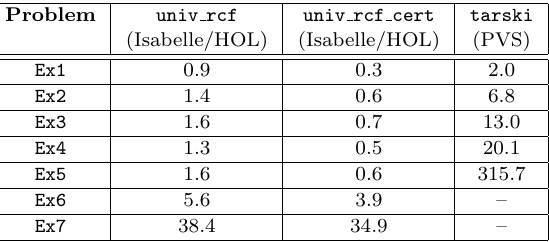
Table II. Comparison between univ rcf vs. tarski as reported in